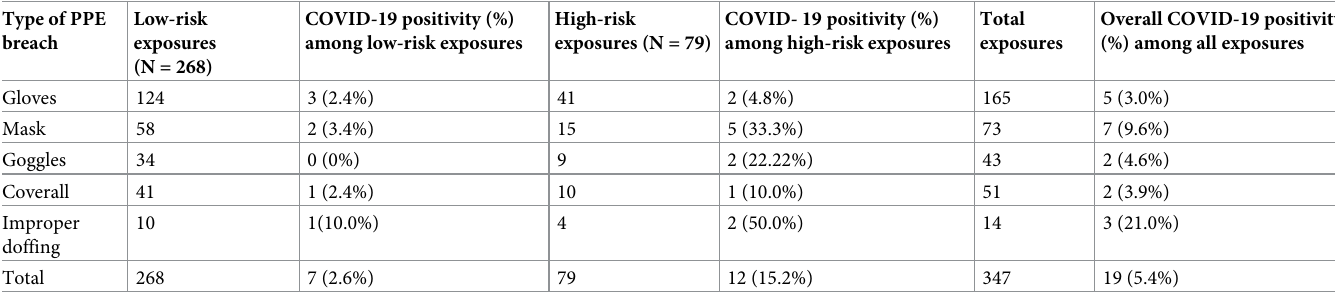
Table 2. Distribution of PPE breaches associated with COVID-19 positivity. Type of PPE Low-risk breach